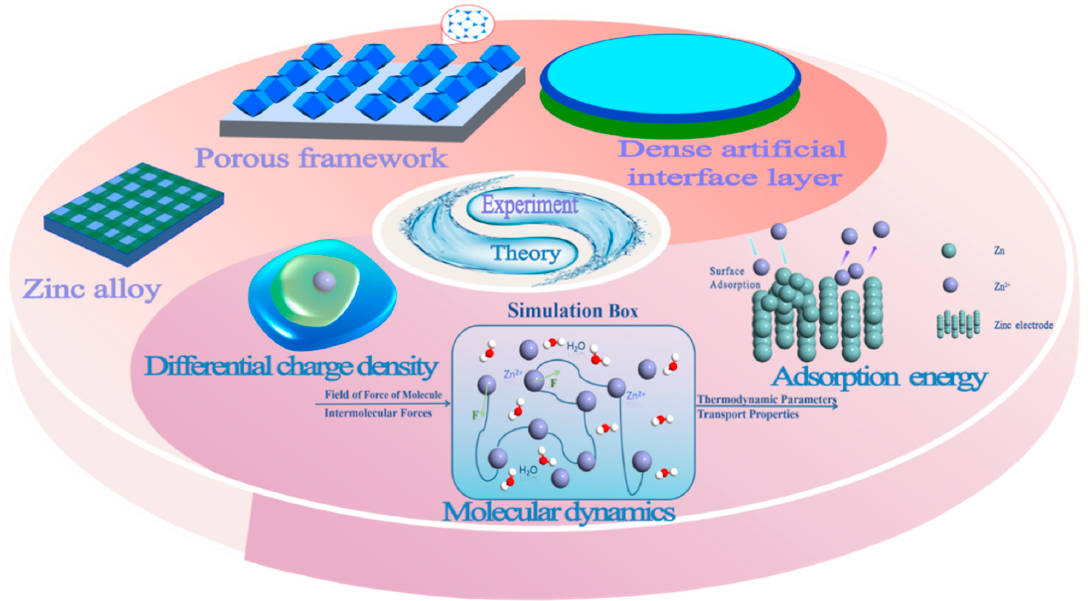
Figure 2. Experimental modi fi cation strategy and theoretical calculation method of a zinc anode.